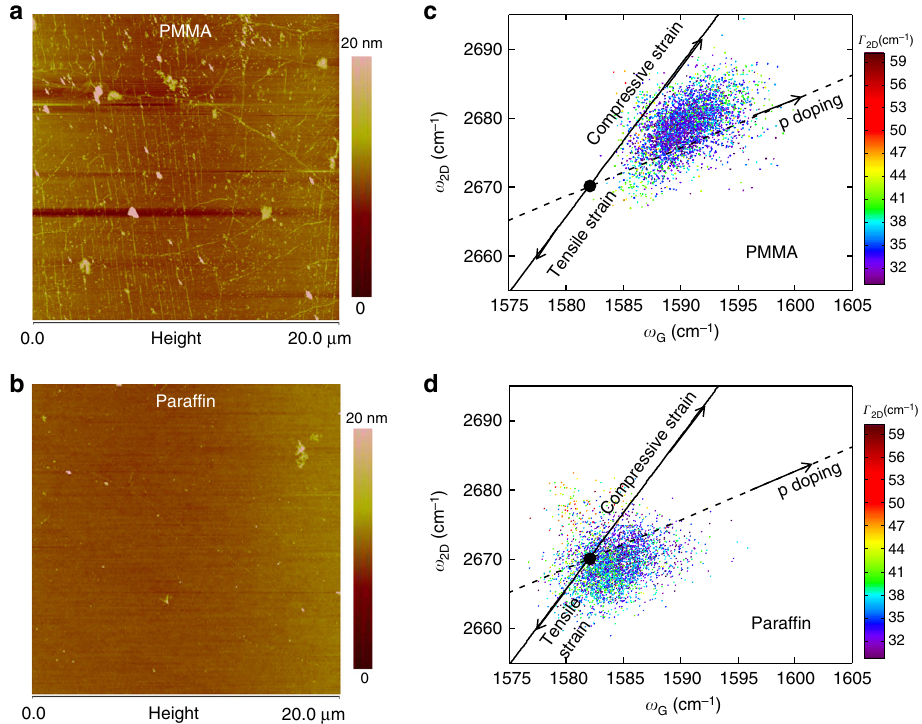
Fig. 4 Materials characterization of the PMMA- and paraf fi n-transferred graphene on Si/SiO 2 substrate. a , b Typical AFM height pro fi le images of graphene fi lm transferred with a PMMA and b paraf fi n support layers. c , d Correlation map of the Raman G and 2D peak positions of graphene transferred with c PMMA and d paraf fi n support layers. A total of 3600 Raman spectra were taken from each type of transferred graphene and the corresponding G peak position ( ω ), 2D peak position ( ω 2 ), and 2D peak ’ s full width at half maximum ( Γ 2D ) were extracted. The black circle represents the G and 2D peak G D positions of an intrinsic graphene, where graphene has neither doping nor